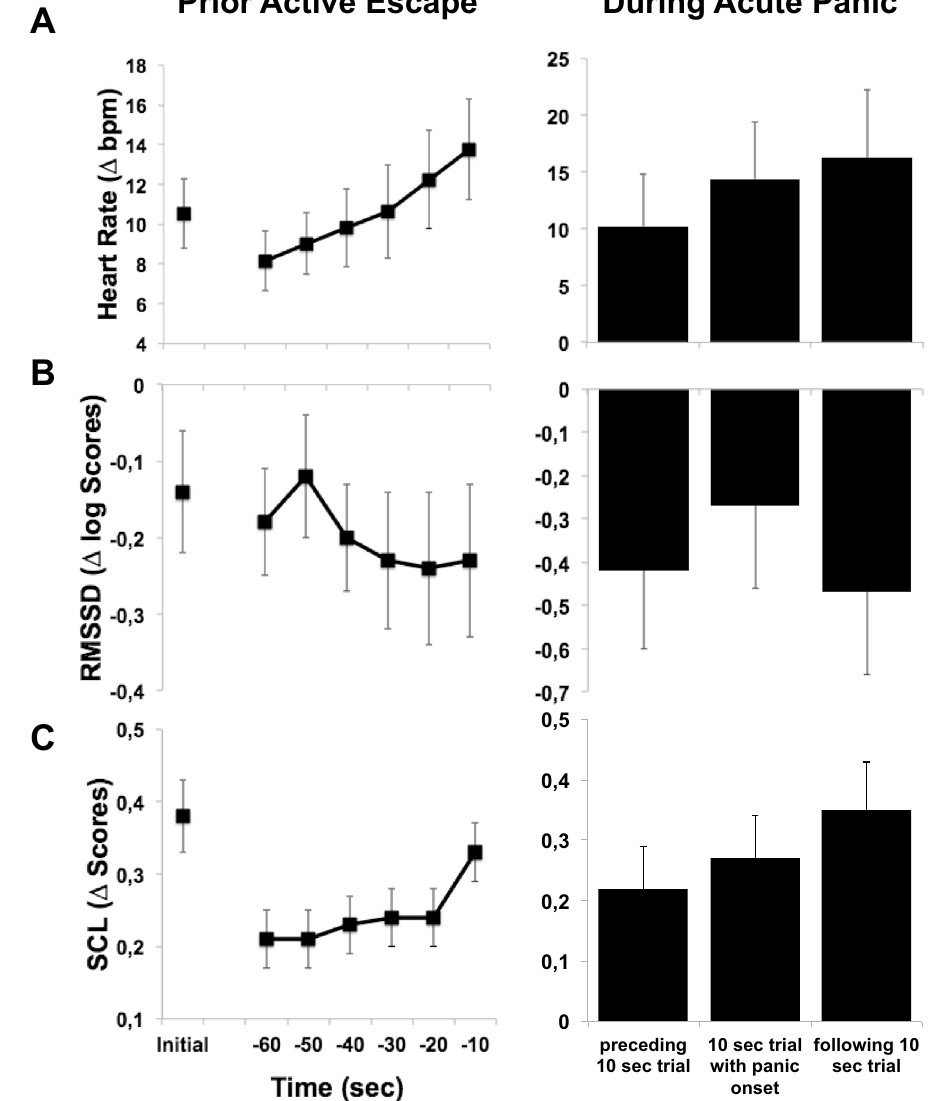
Figure 3. Physiological responses (means and standard errors) during imminent threat relative to a safe condition. Left column: The initial 10 s block of acute threat exposure and last six 10 s blocks prior to individual active avoidance behavior in n = 46 patients showing active avoidance behavior but a minimum exposure duration of 60 s. Right column: The 10 s block including individual panic attack onset and the respective block before and after in n = 18 recorded panic attacks. ( A ) Heart Rate in bpm, beats per minute. ( B ) Heart rate variability in logarithmic RMSSD scores, root mean square of successive differences. ( C ) Range corrected skin conductance levels (SCL). SCL data of 43 patients and 17 panic attacks were available prior active escape and during acute panic,